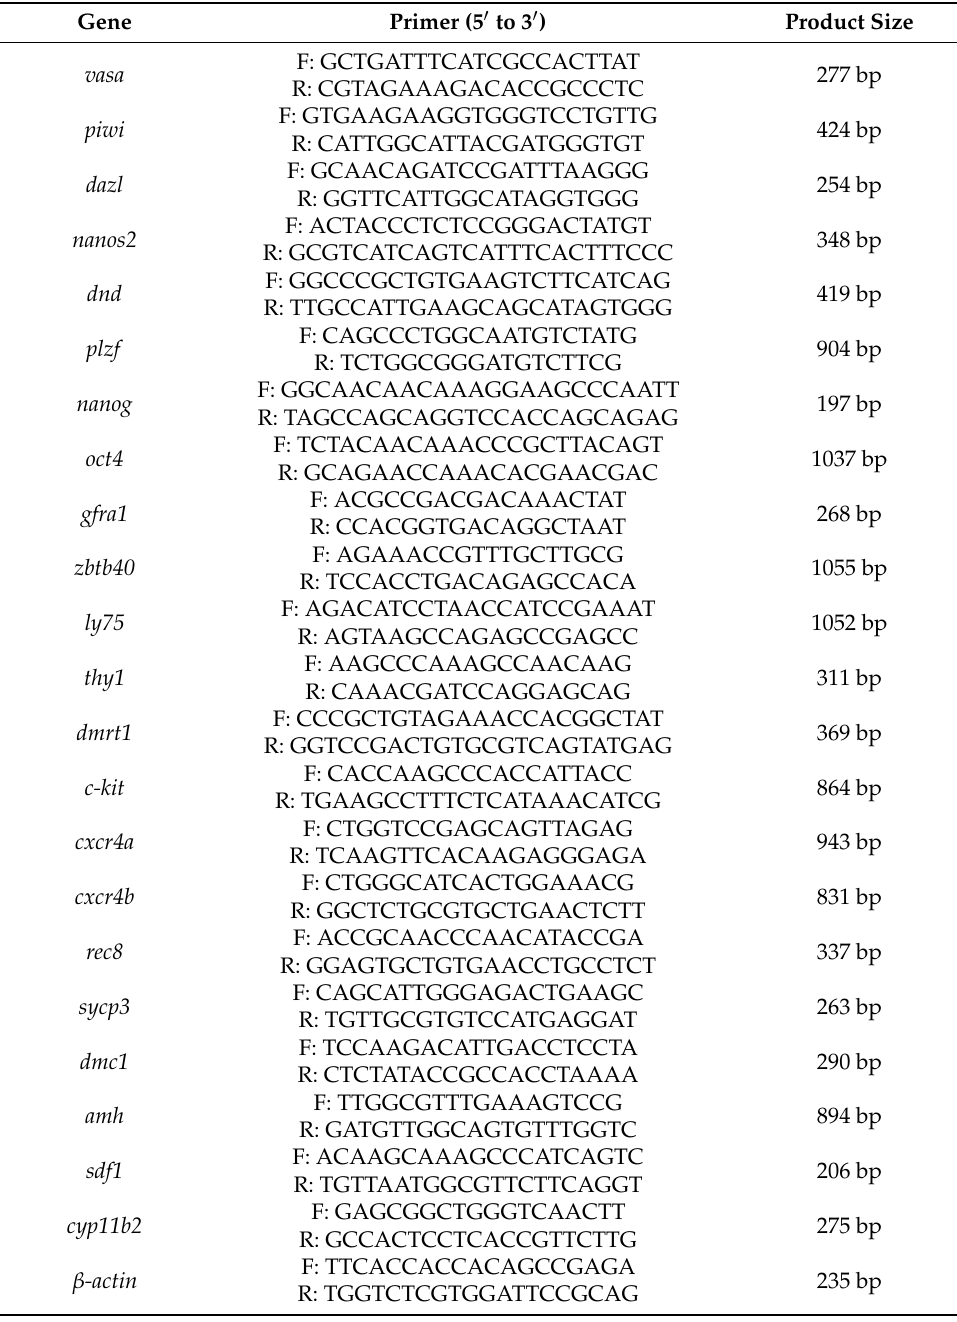
Table 1. Primers for RT-PCR and in situ hybridization